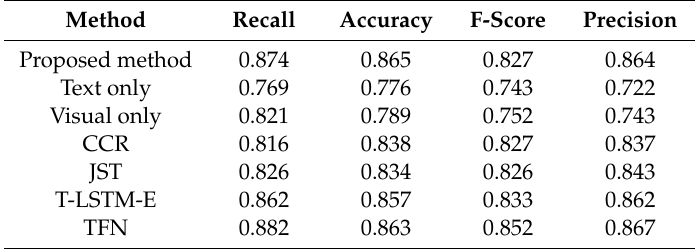
Table 2. Performance of various sentiment analysis methods on